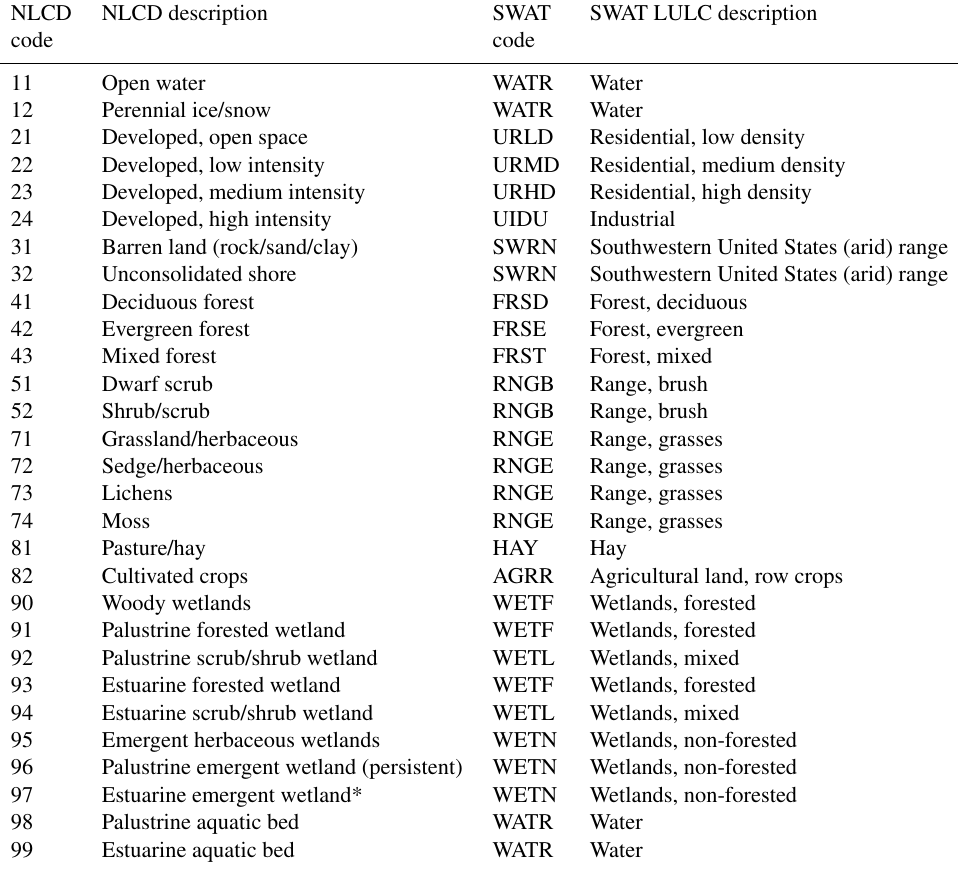
Table A3. Original SWAT database land use/land cover lookup